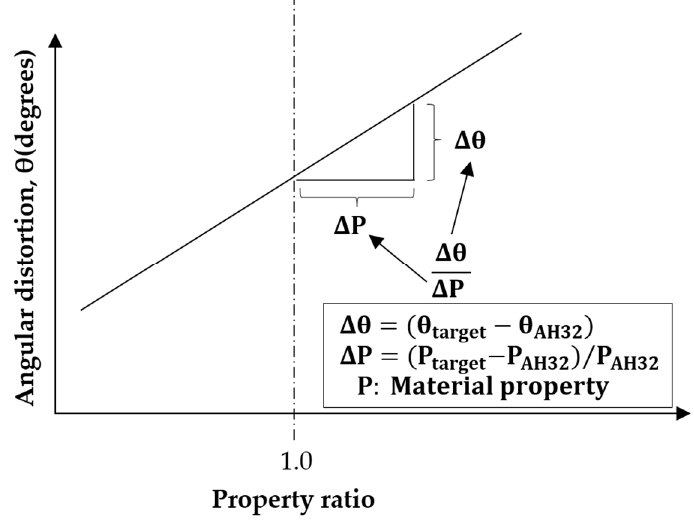
Figure 10. Definition of material property ratio.